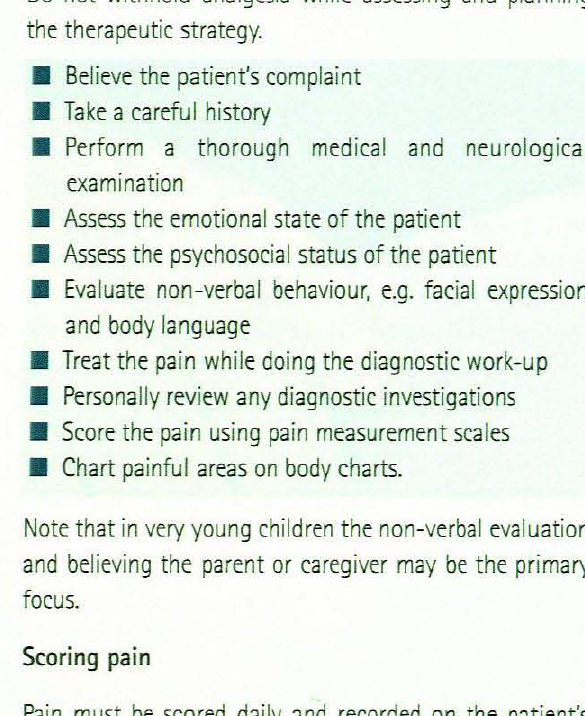
Visual analogue scale: